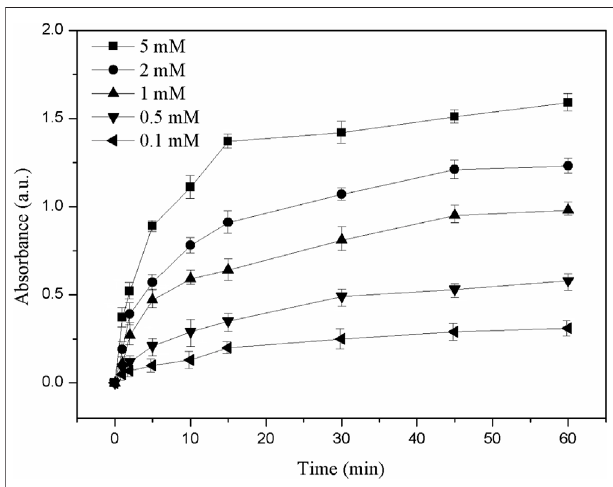
FIGURE 13 | UV absorbance change of TMB (653 nm) with different concentrations of (mM).